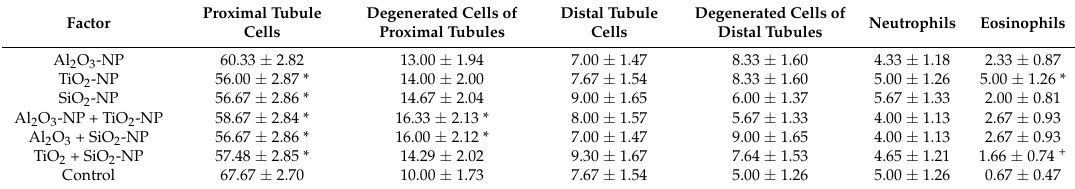
Table 9. Some Cytological Characteristics of Kidney Tissue Imprints as a Percentage of Total Cell Count in Rats after Subchronic Exposure to Al 2 O 3 -NP, TiO 2 -NP and SiO 2 -NP Individually or in Binary Combinations (x ±